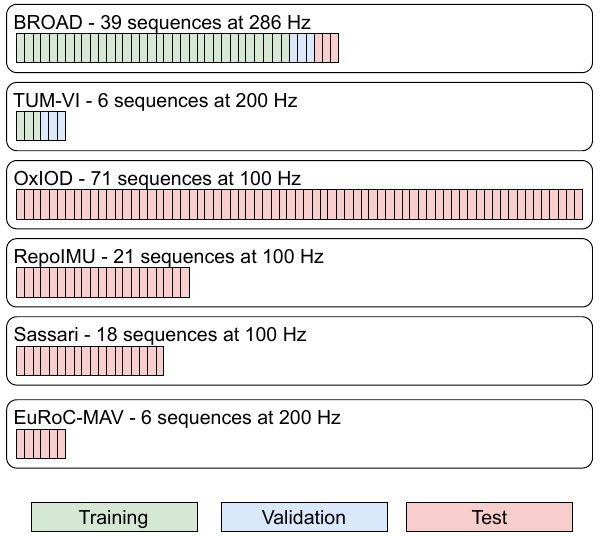
Figure 3. The dataset collection is composed of six publicly available datasets, which are split into training, validation, and test data. While the validation data is used to find the best performing network configuration and hyperparameters, the test data is reserved for the final performance evaluation in Section 5.